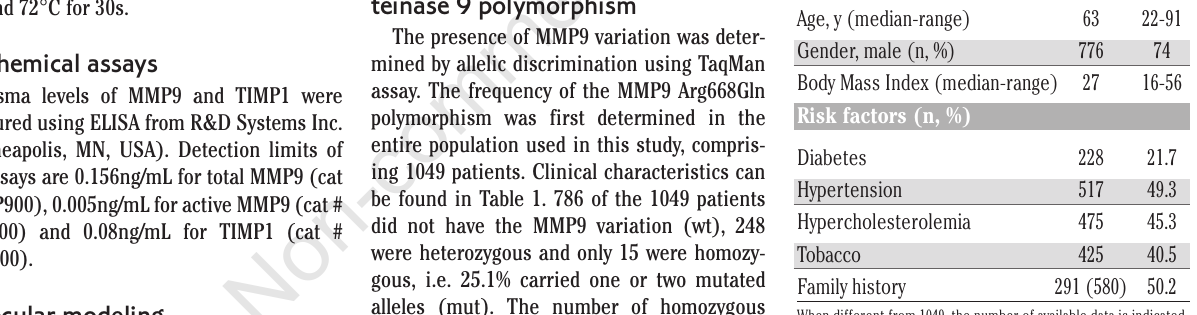
Figure 1. Frequency of the MMP9 Arg668 Gln polymor- phism in con- trols, STEMI, NSTEMI and angina patients. Frequencies were c o m p a r a b l e between the 4 groups (P=0.68). Cont: controls.